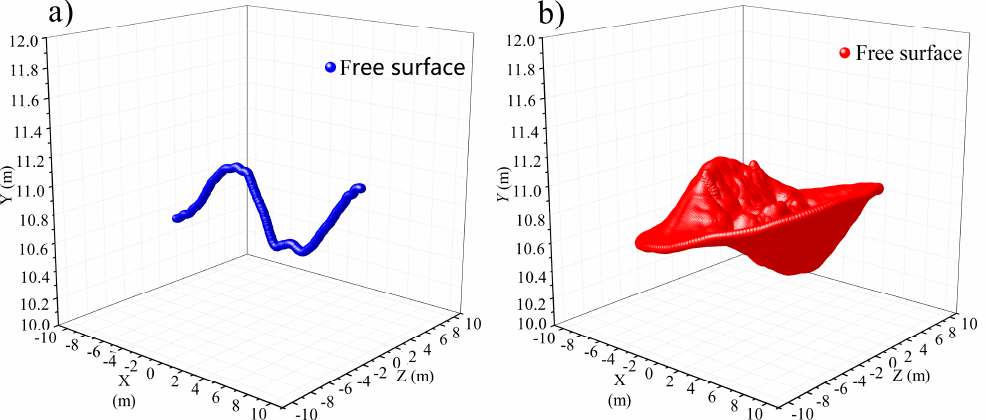
Figure 7. Free surface shape of the sloshing in the water tank under the IV earthquake, ( a ) 2D case, t = 10.25 s, ( b ) 3D case, t = 10.25 s.